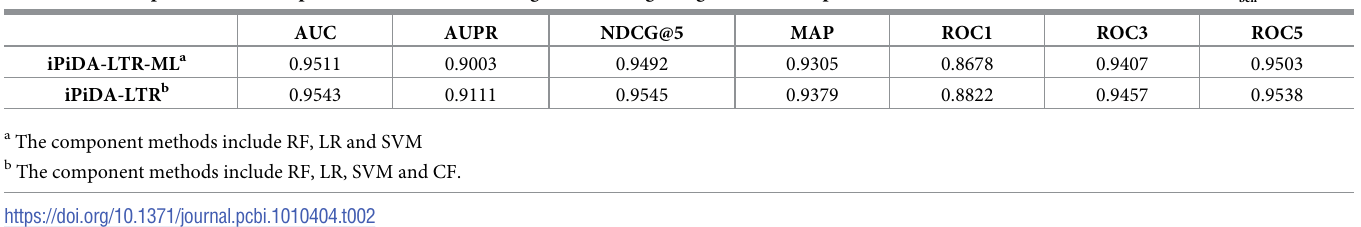
Table 2. The comparison results of predictors based on Learning to Rank integrating different component methods via five-fold cross-validation on S a